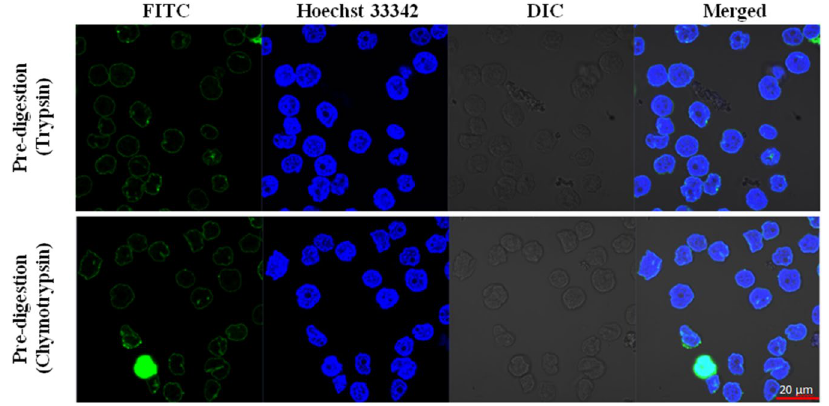
Figure 3. Sulfo-NHS-SS-biotin does not penetrate the plasma membranes of enzyme-treated cells. The cells were treated with the previously determined maximal tolerable trypsin or chymotrypsin concentrations, biotinylated and location of the dyes and cells were detected (from left to right: FITC conjugated anti-biotin antibody fluorescence, Hoechst 33342 DNA dye fluorescence, Differential Interference Contrast (DIC) and Merged picture). Red scale bar: 20 µ m. Zeiss ZEN lite software (Carl Zeiss, Oberkochen, Germany) was used to acquire